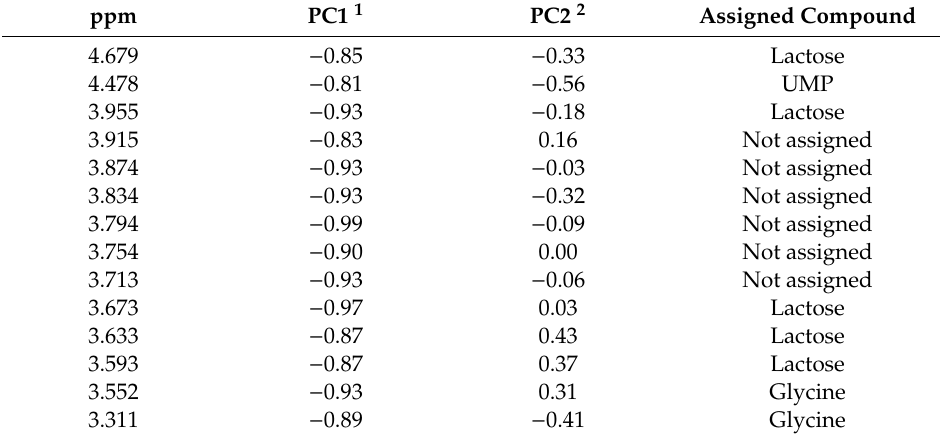
Table 3. Most correlated bins of swine colostrum obtained from the principal component analysis (PCA) carried out on the binned matrix.